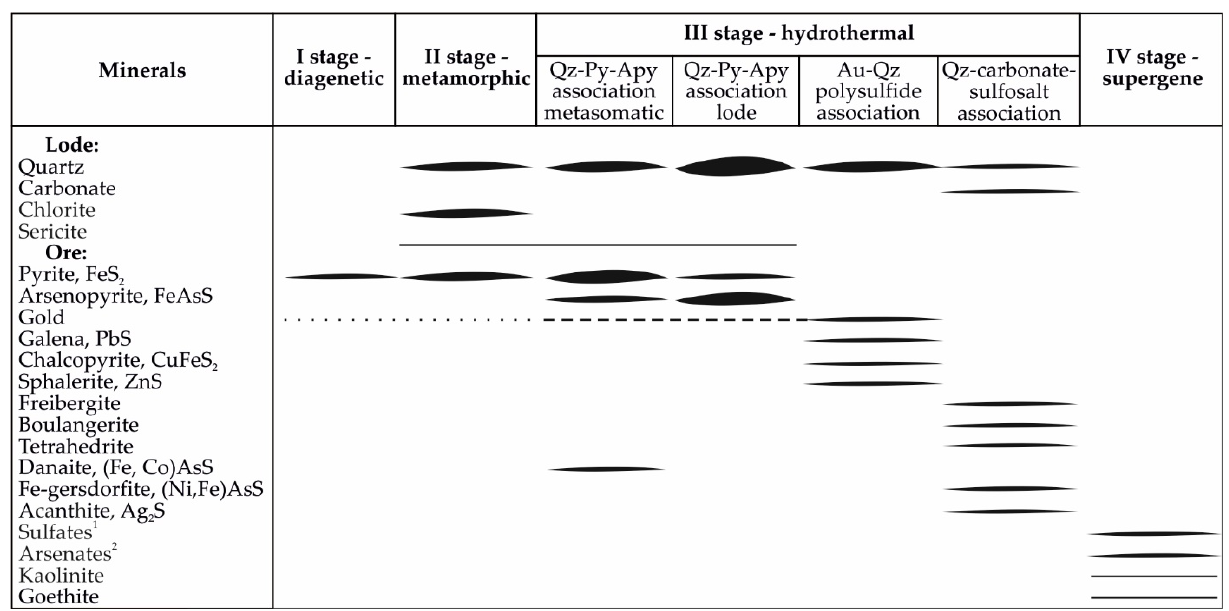
Figure 4. Mineral paragenesis for Khangalas deposit. 1 Sulfates: gypsum, jarosite, mangazeite, amarantite, meta-aluminite, meta-alunogen, tamarugite, pickeringite, unknown hydrous iron sulfate [40]. 2 Arsenates: scorodite, kankite, bukovskiite, unknown Fe-Al arsenate-phosphate-sulfate [41].